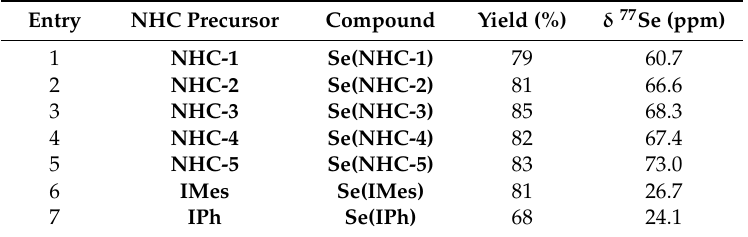
Table 1. Percentage yields and 77 Se NMR chemical shift data of selenium-NHC adducts.